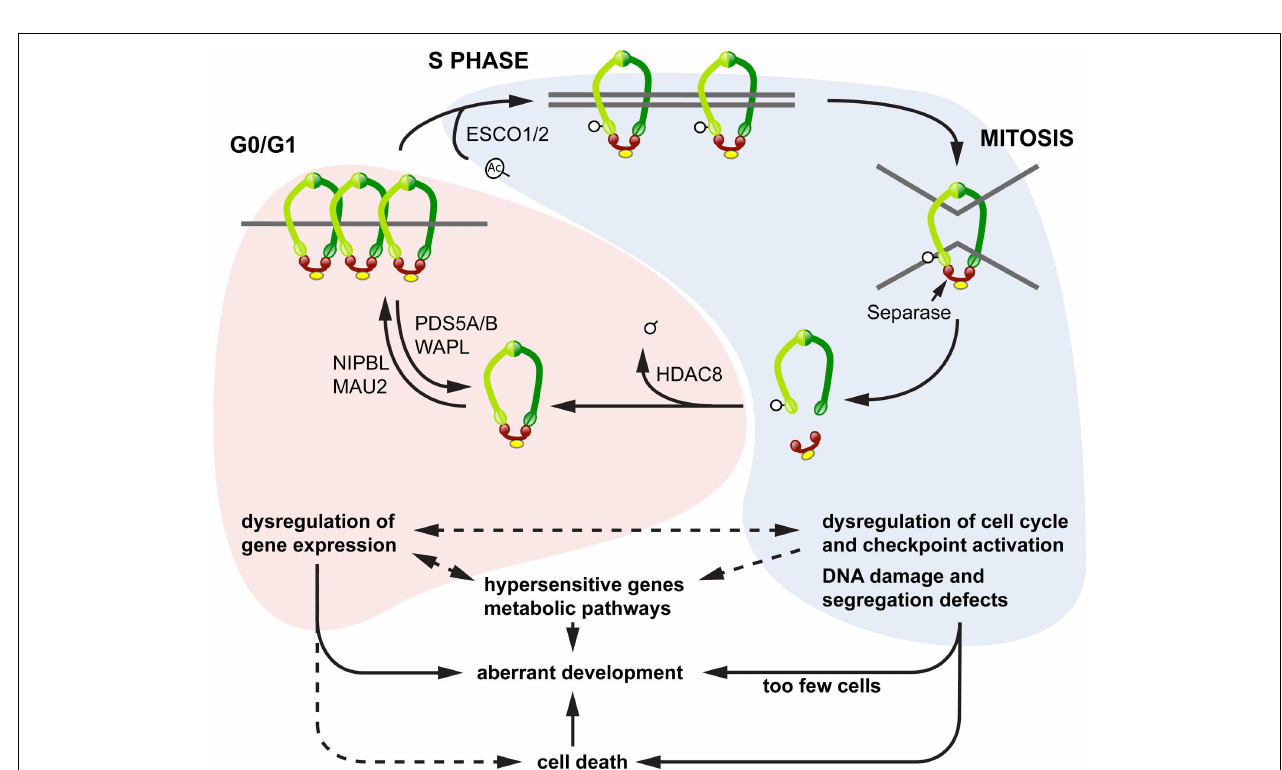
overriding function of cohesin involves sister chromatid cohesion and DNA damage repair. Key regulators in this process include the CoAT ESCO2 and other DNA damage repair proteins. Mutations in these regulators result in chromosome segregation defects, genomic instability, and cell death. Increased cell death and reduced cell proliferation results in too few cells to make up body structures, leading to a different class of developmental defects and dysregulation of metabolic pathways.Transcription of a small subset of hypersensitive genes, including some in the Notch signaling pathway, appears to be sensitive to both interphase and S/G2 modes of cohesin